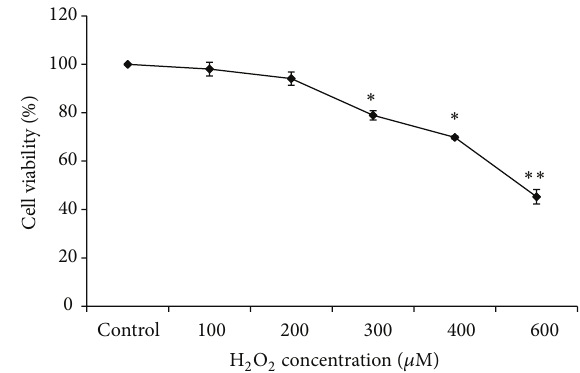
Figure 1: Effect of H 2 O 2 on the cell viability of feline EECs. Serum- starved EECs were incubated with H 2 O 2 for 24 hours at the indicated concentration. The cell viability was estimated using MTT assay. Data are expressed as means ± S.E of three experiments (Student’s t -test; ∗ 𝑃 < 0.05 versus control; ∗∗ 𝑃 < 0.001 versus